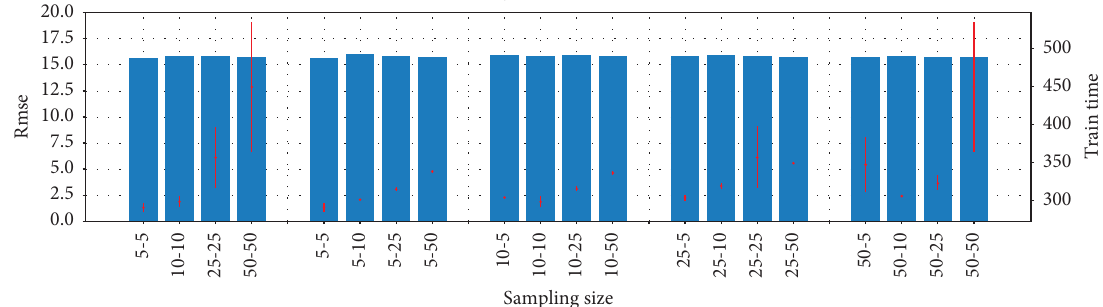
Figure 8: RMSE and training time when using different sampling sizes in two layers of FastGCN.